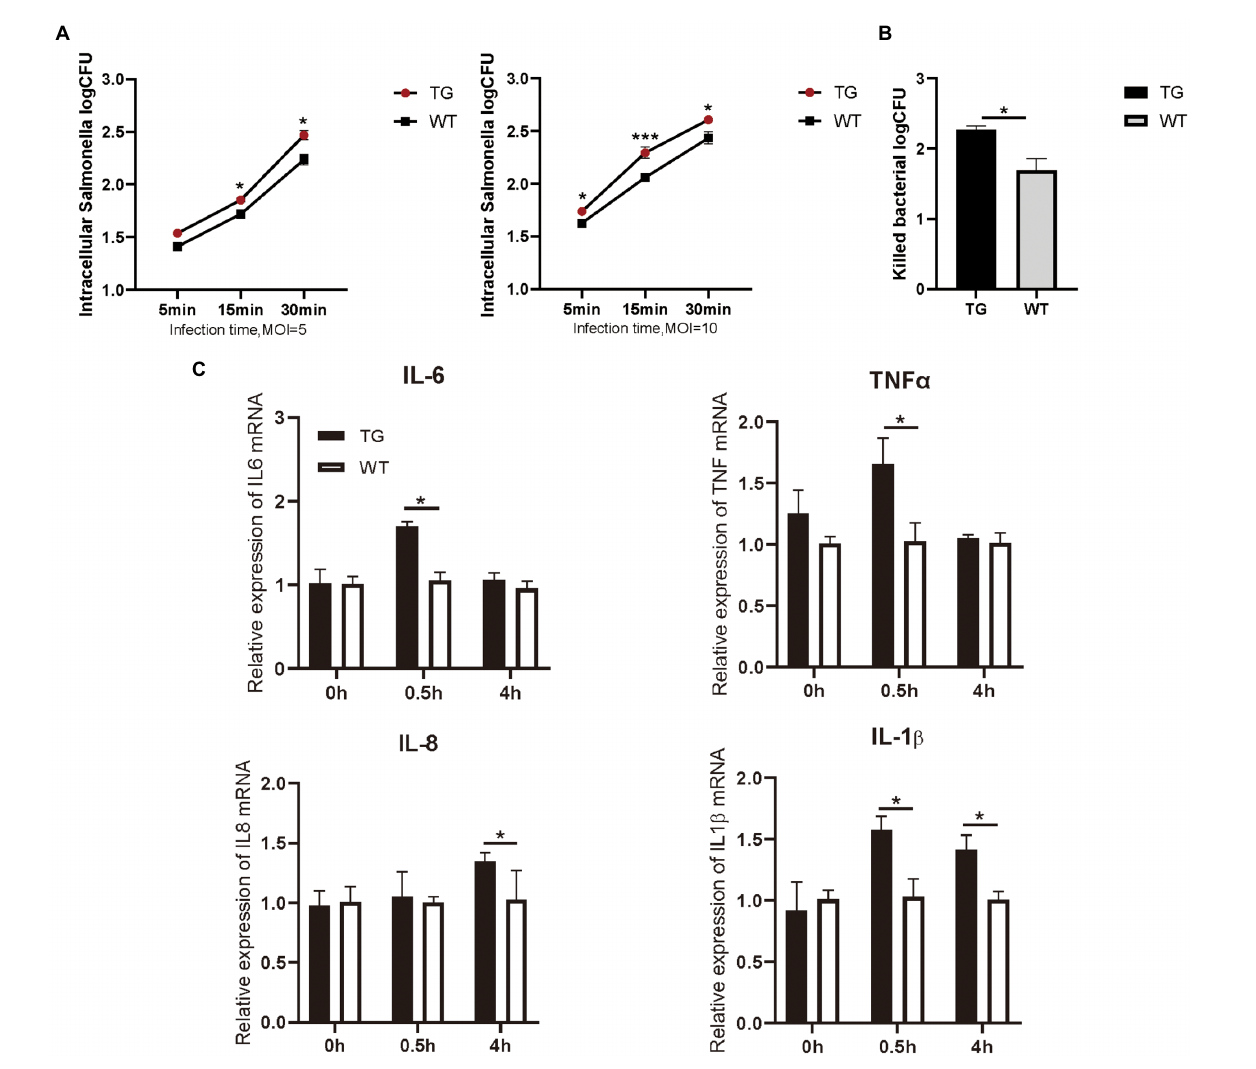
FIGURE 2 TLR4-overexpressing promotes the activation of cytokines and increases S. Typhimurium phagocytic uptake and killing. (A) Different infection times with S. Typhimurium (MOI = 5 or 10) and intracellular S. Typhimurium were detected in TG and WT macrophages. (B) The clearance of S. Typhimurium in macrophages was analyzed by CFU method. Macrophages were treated with S. Typhimurium (MOI = 10) for 30 min. After 30 min, survived S. Typhimurium in macrophages were counted by CFU plating. (C) The expression levels of the pro-inflammatory cytokines like IL-6, TNF α , IL-8 and IL-1 β were determined in macrophages by qRT-PCR after S. Typhimurium for 0, 0.5, and 4 h. N = 4; * p < 0.05, *** p < 0.001. TG, transgenic; WT, wild-type; MOI, multiplicity of infection; CFU, colony-forming